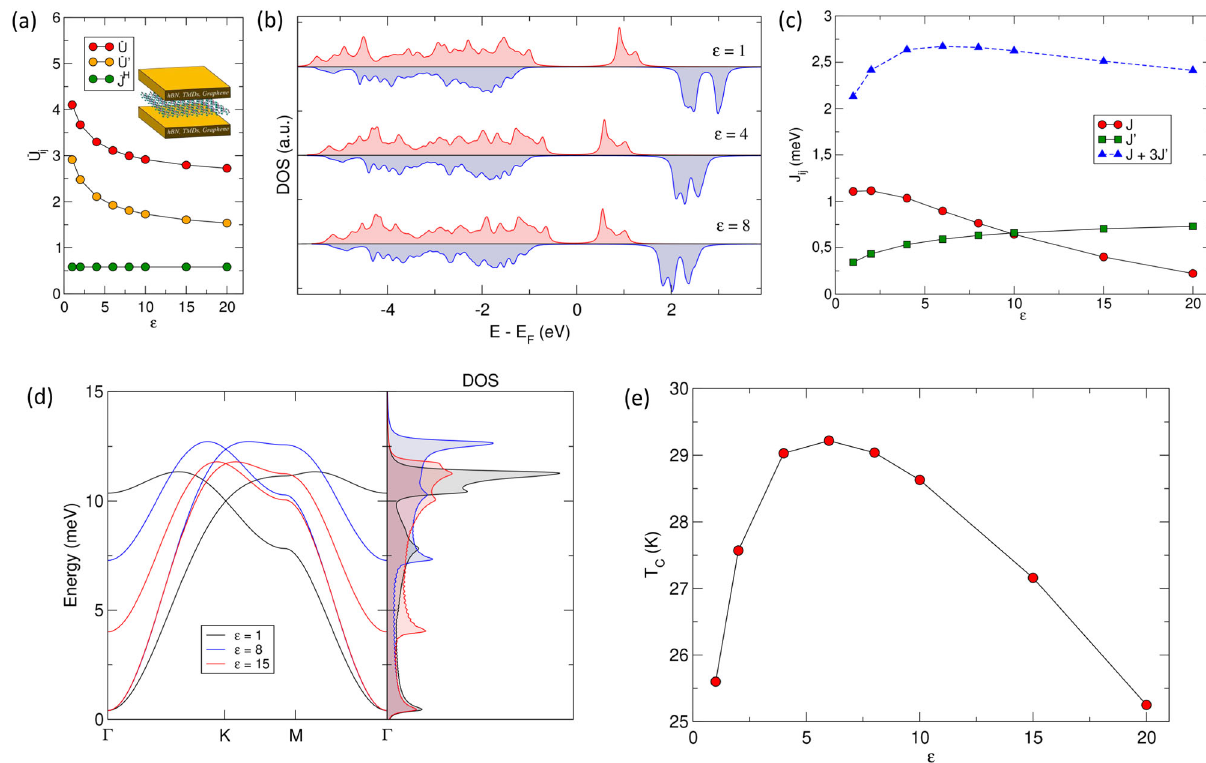
Fig. 5 Substrate screening effects. a Local Coulomb interactions: red, yellow, and green dots correspond to orbital-averaged intra- ( U ) and interorbital ( U 0 ) Coulomb and Hund ’ s exchange ( J H ) interactions. The inset sketches an encapsulated monolayer CrI 3 . b Electronic density of states for ϵ = 1, ϵ = 4, and ϵ = 8. d Nearest and next-nearest neighbor magnetic exchange interactions J and J 0 , respectively. The function J þ 3 J 0 is shown for reference (see text for details). e Curie temperature. Table 4. Orbital-resolved nearest- and next-nearest neighbor exchange interactions in CrI 3 monolayer calculated for different substrate dielectric screening constants in meV.